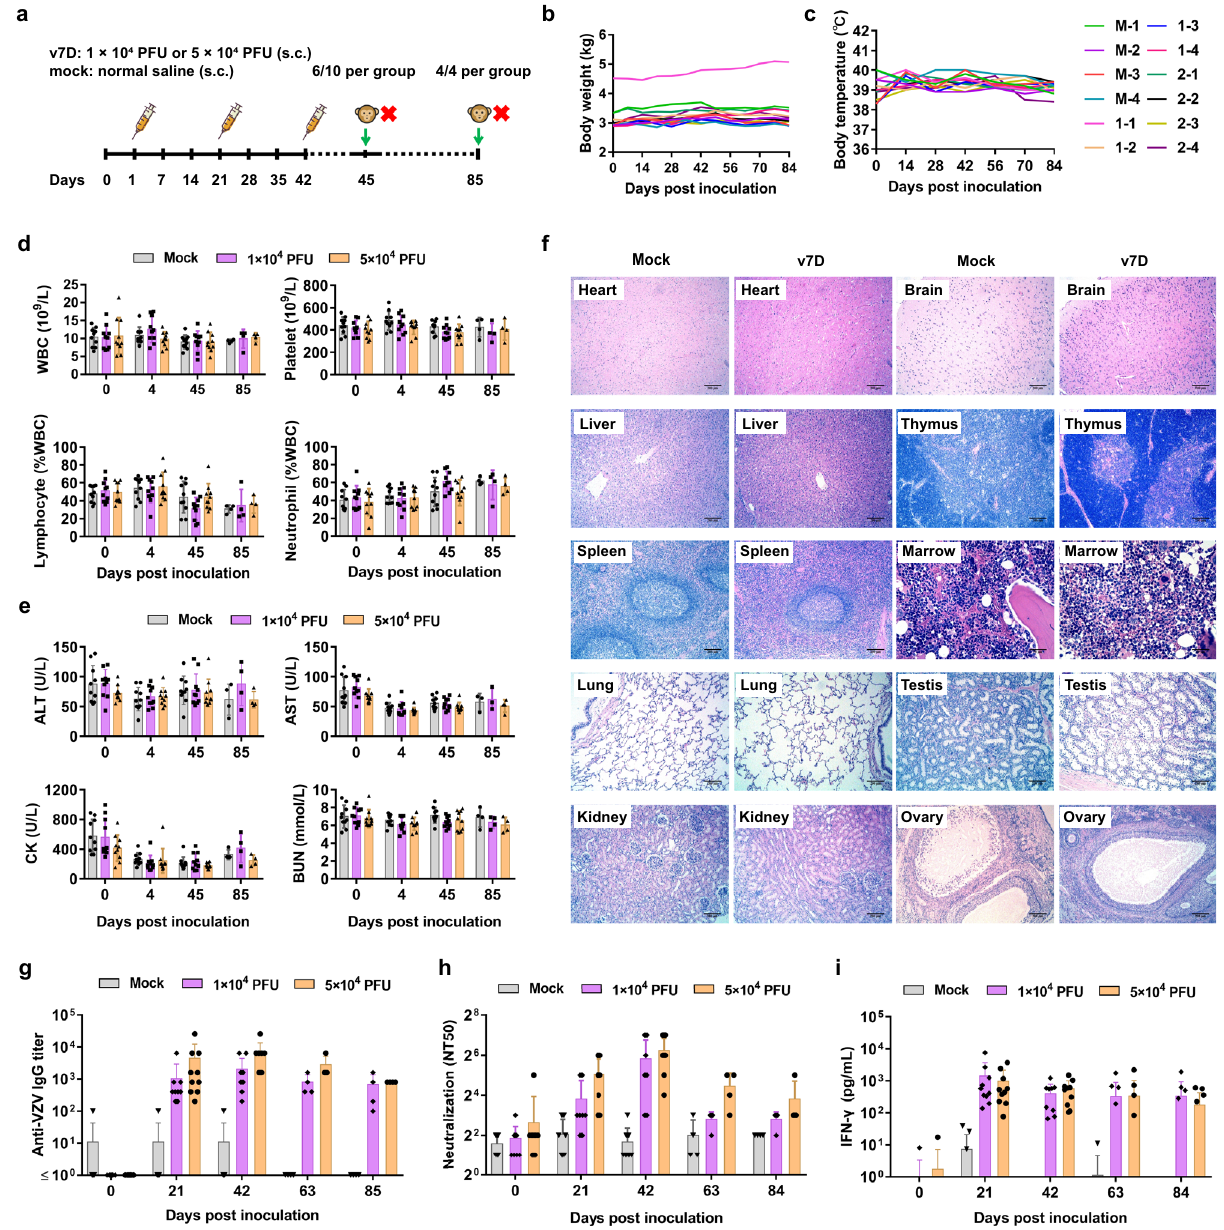
Fig. 7 Toxicity and immunogenicity of repeated subcutaneous injections of v7D in nonhuman primates. a Timeline of the experimental setup for the repeated subcutaneous dose toxicity study in cynomolgus macaques. Ten animals per group were inoculated subcutaneously with 1 × 10 4 PFU (group 1) or 5 × 10 4 PFU (group 2) of the v7D virus or an equal volume of normal saline three times as indicated. b , c Body weights and body temperature of four animals in each group were monitored throughout the study. M the mock group, V the v7D group, 1 v7D group 1, 2 v7D group 2. d , e Hematological parameters and serum chemistry parameters of the animals ( n = 10 per group at day 0, 4, and 45, and n = 4 per group at day 85) were analyzed at the indicated time points. ALT alanine transaminase, CK creatine kinase, AST aspartate aminotransferase, BUN blood urea nitrogen. f Representative histopathological images of the major organs from cynomolgus macaques following repeated subcutaneous administration of 5 × 10 4 PFU of v7D at 45 dpi. The experiment was repeated twice with similar results. Scale bars: 200 μ m or 50 μ m as indicated in the respective images. g – i Blood samples collected from these cynomolgus macaques ( n = 10 per group at day 0, 21, and 42, and n = 4 per group at day 63 and 85) were evaluated for anti-VZV IgG antibody titers and neutralizing antibody titers, and PBMCs were analyzed for IFN- γ responses in response to VZV antigens. In ( d , e ) and ( g – i ), the results are represented as averages± the SD. Source data are provided as a Source Data fi extensively evaluated in target cells/tissues of the natural host. syncytia formation during VZV infection 31 , severely impaired Therefore, the observed severe defect in VZV virion packaging viral spreading of v7D within skin or nerve tissues could be due to caused by ORF7 de fi ciency in human target cells/tissues should the incapacity of the virus to fuse skin cells or fuse satellite cells constitute one mechanism contributing to v7D attenuation and with sensory neurons. Thirdly, despite having similar functions as be presented as a solid evidence supporting the safety of v7D for its homologs in virion cytoplasmic envelopment, VZV ORF7 clinical use. is, to our knowledge, the only one of its kind that has been